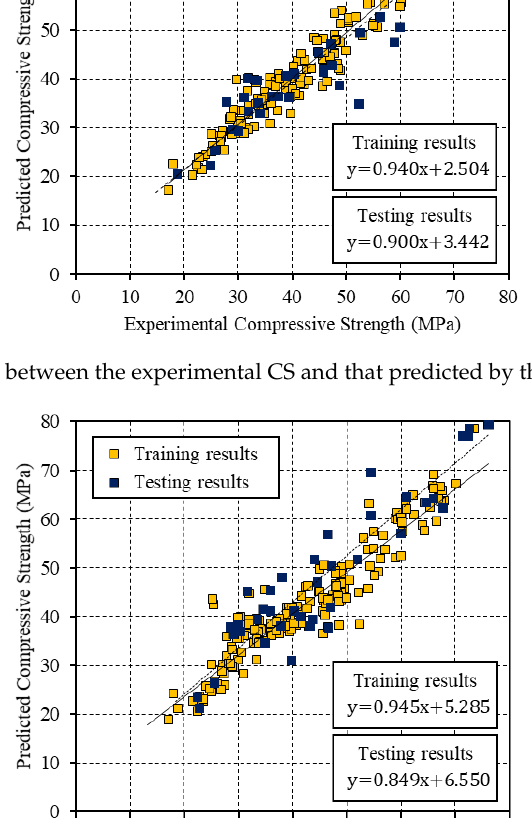
Figure 5. Comparison between the experimental CS and that predicted by the PSO neural network.